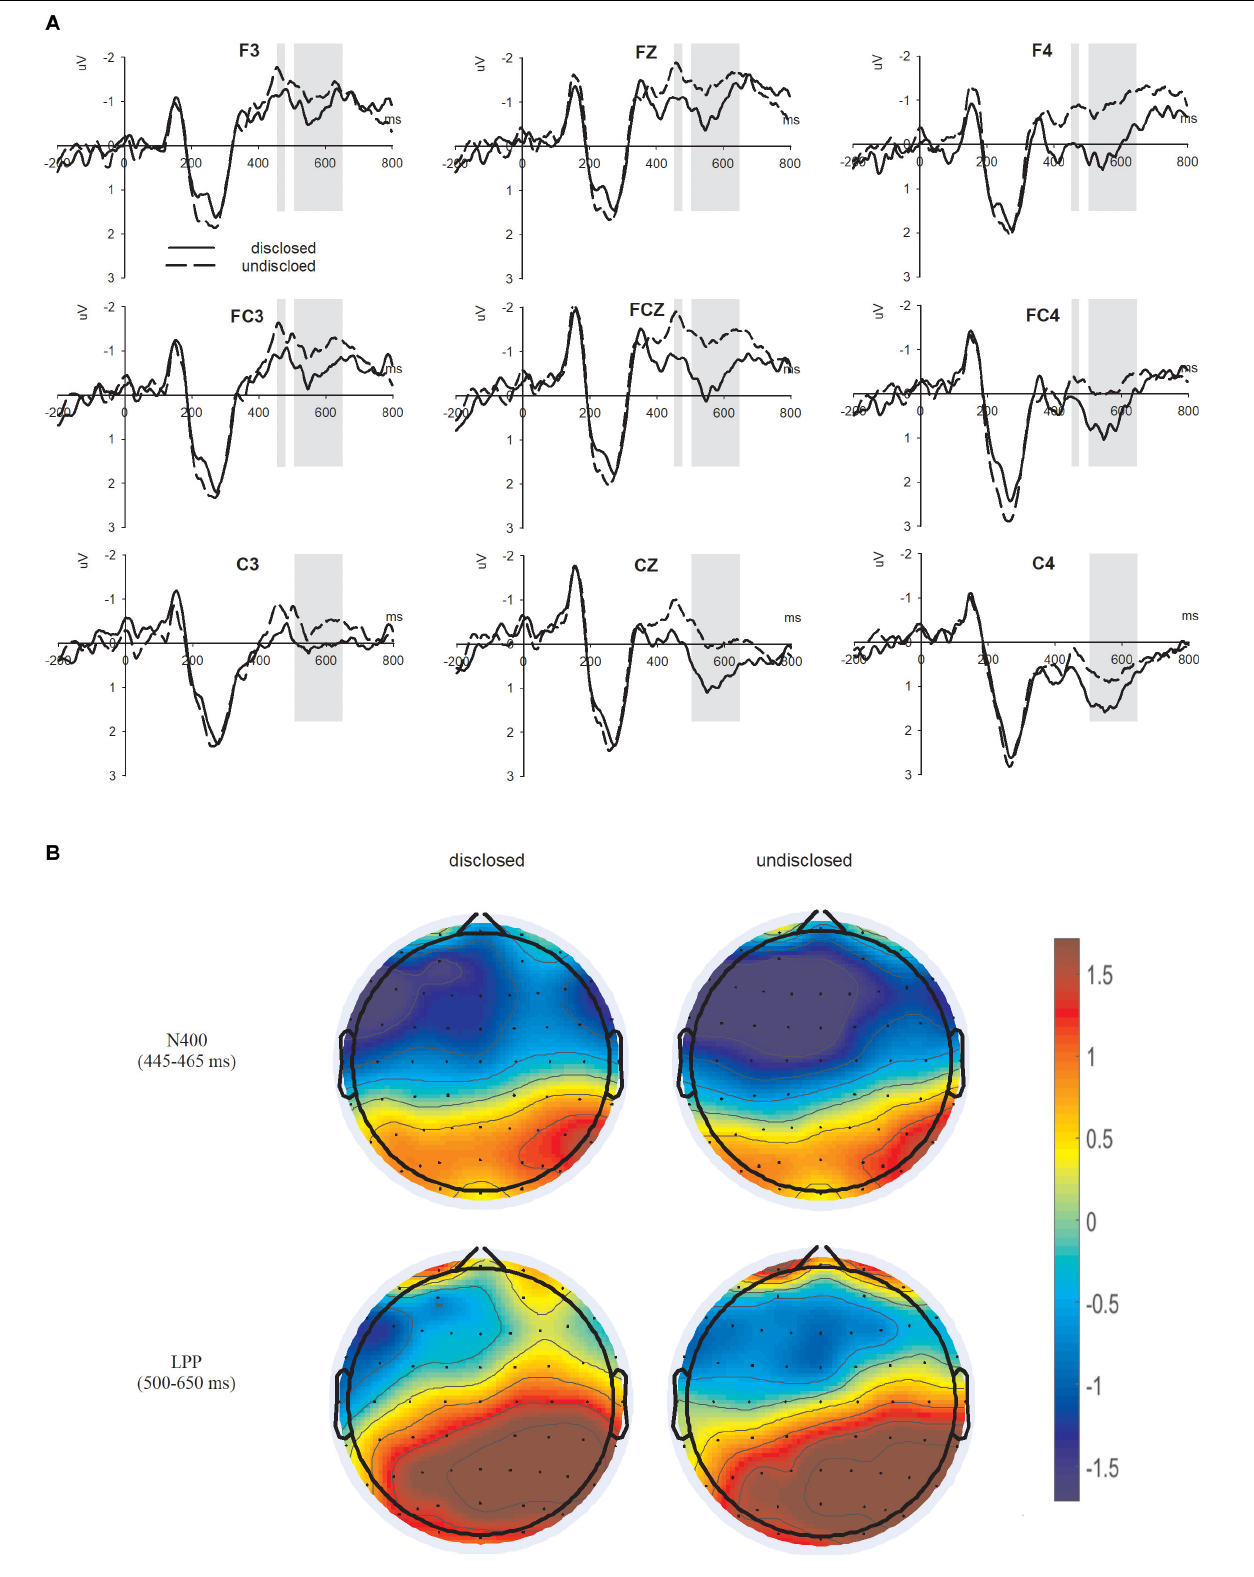
FIGURE 3 | ERPs results. (A) the grand average waveforms at nine electrodes. (B) The topographic distributions of the waves of N400 and LPP.